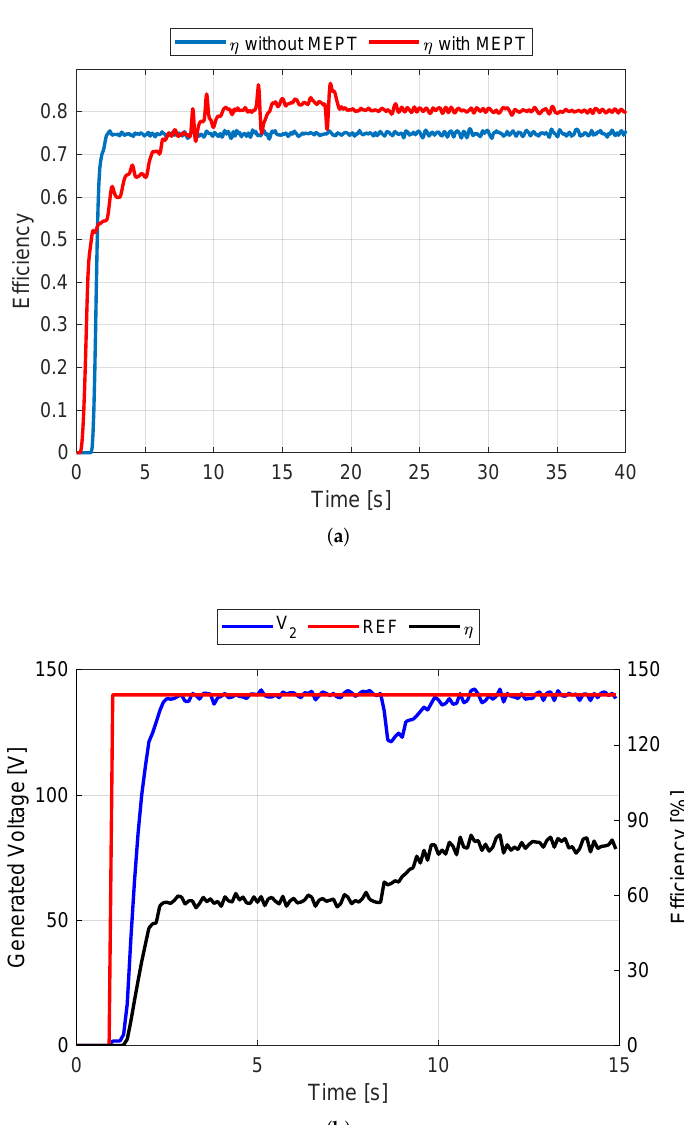
Figure 18. Simulation and experimental results for 140 V reference: ( a ) Simulation result: efficiency increase with MEPT algorithm; ( b ) Experimental result: controller performance and GRC